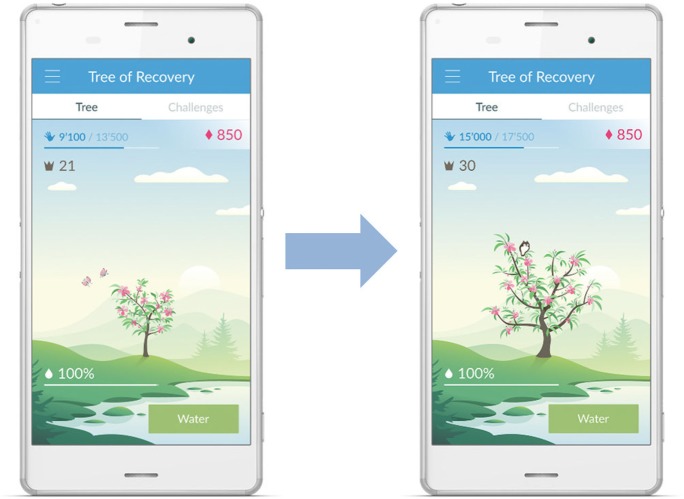
“Tree of Recovery.” Legend: a figurative representation of the amount of upper limb use in daily life. Arm Activities are displayed in blue numbers and the earned diamonds in red.